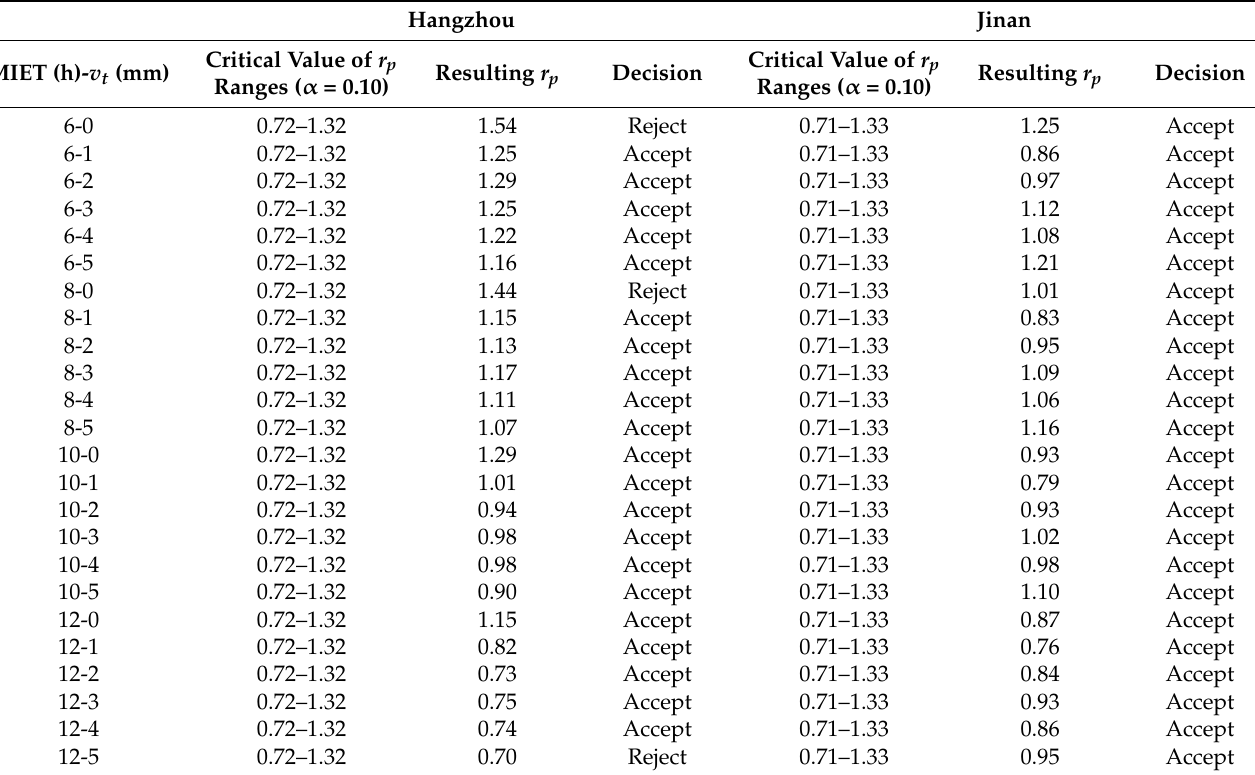
Table 4. Results of Poisson Tests for Hangzhou and Jinan—Annual Number of Rainfall Events. Hangzhou